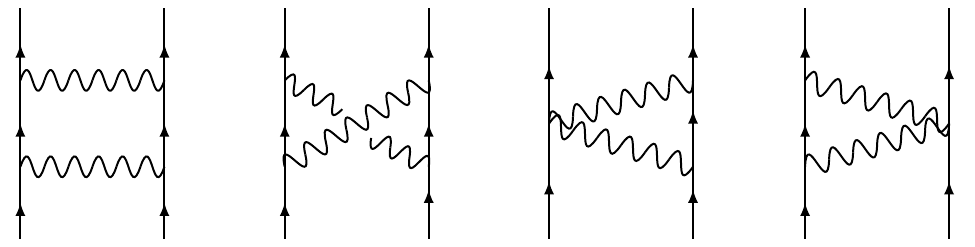
Figure 2. The topologies forming the basis for the 2PM